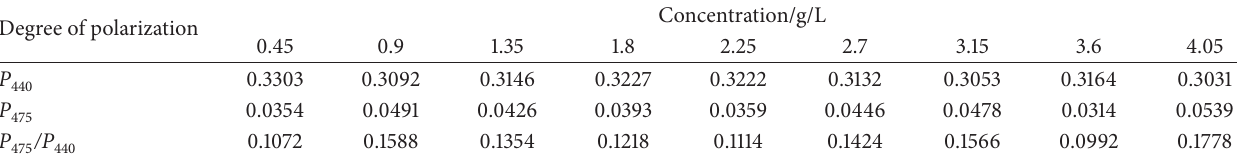
Table 3: Polarization degree and ratio with different